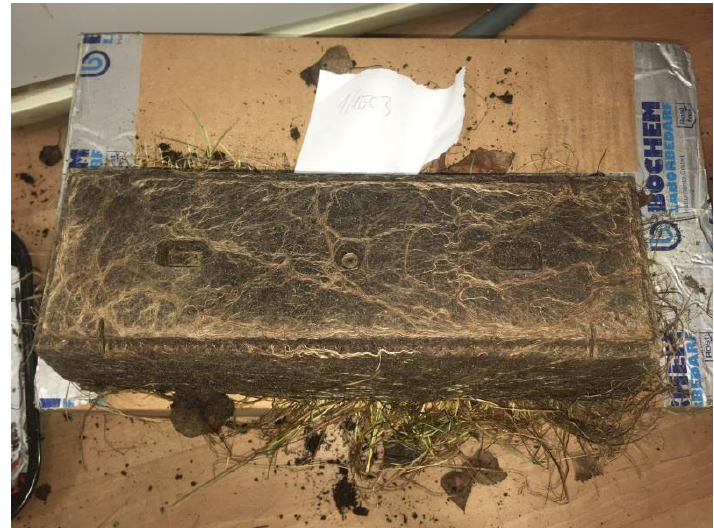
Figure 15. Root ball in Series 3 (B. Vojvodikova).